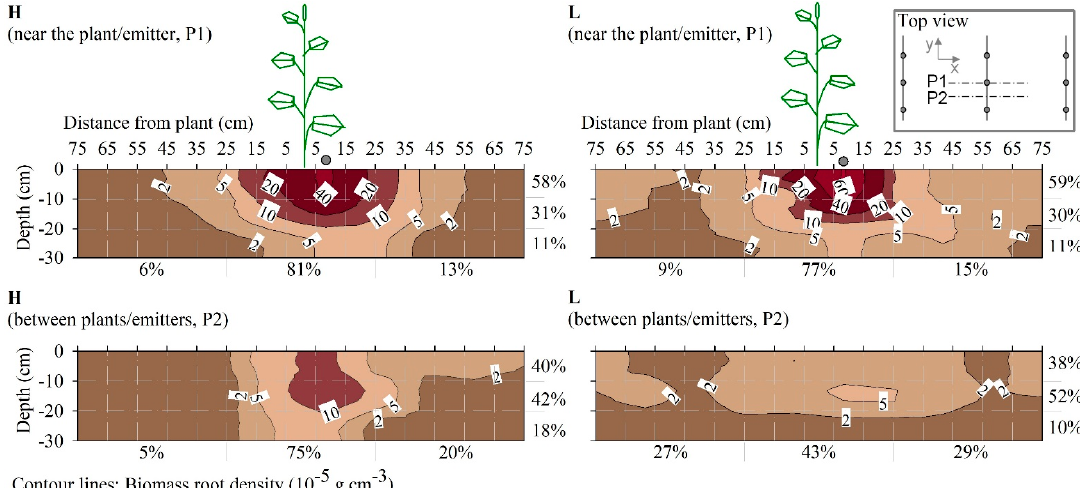
Figure 3. Root biomass distribution across soil profiles perpendicular to plant rows near the emitter and the plant (P1), and between two adjacent plants (P2) at the end of an autumn–winter cucumber crop cycle grown under high (H) and low (L) soil water availability. Contour lines represent mean biomass root density values (10 − 5 g cm − 3 ). Percentage values represent the root biomass of the zone relative to the total biomass, i.e., root biomass distribution in depth (in the upper 0.1 m, between 0.1 m and 0.2 m, and between 0.2 m and 0.3 m depth) and root biomass distribution within the soil profile (in the left, central and right part of the profile); : Emitter.